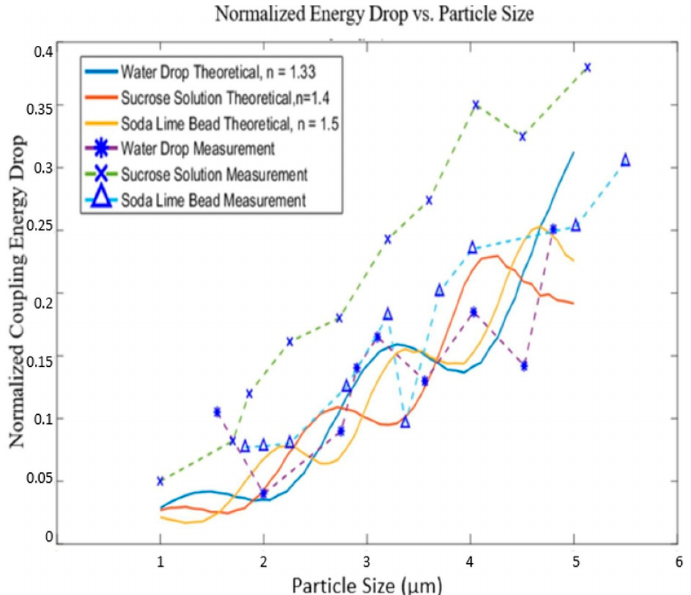
Figure 5. Solid lines are calculations of the loss as a function of particle given refractive index and particle size. The dotted lines connect experimental data where the particle size is determined by the cut-off point of the cyclone at a given flow rate and the largest signal excursions are assumed to be caused by particles with sizes equal to the cut-off plus 0.5 µm.